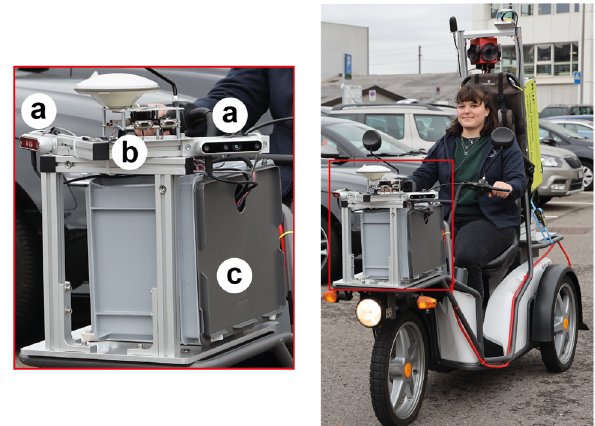
Figure 1 . eMMS with low-cost sensor setup consisting of a) two RGB-D cameras, b) a GNSS and IMU-based navigation unit and c) a